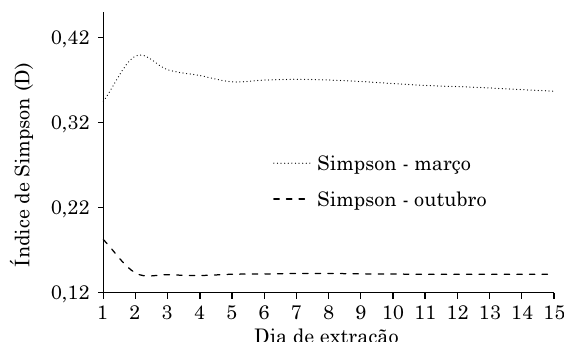
Figura 1. Variação diária do índice de Simpson (D), em razão da quantidade de organismos capturados, discriminada por época de avaliação: em outubro, um dia antes do plantio das leguminosas; e, em março, por ocasião do corte da parte aérea das plantas.